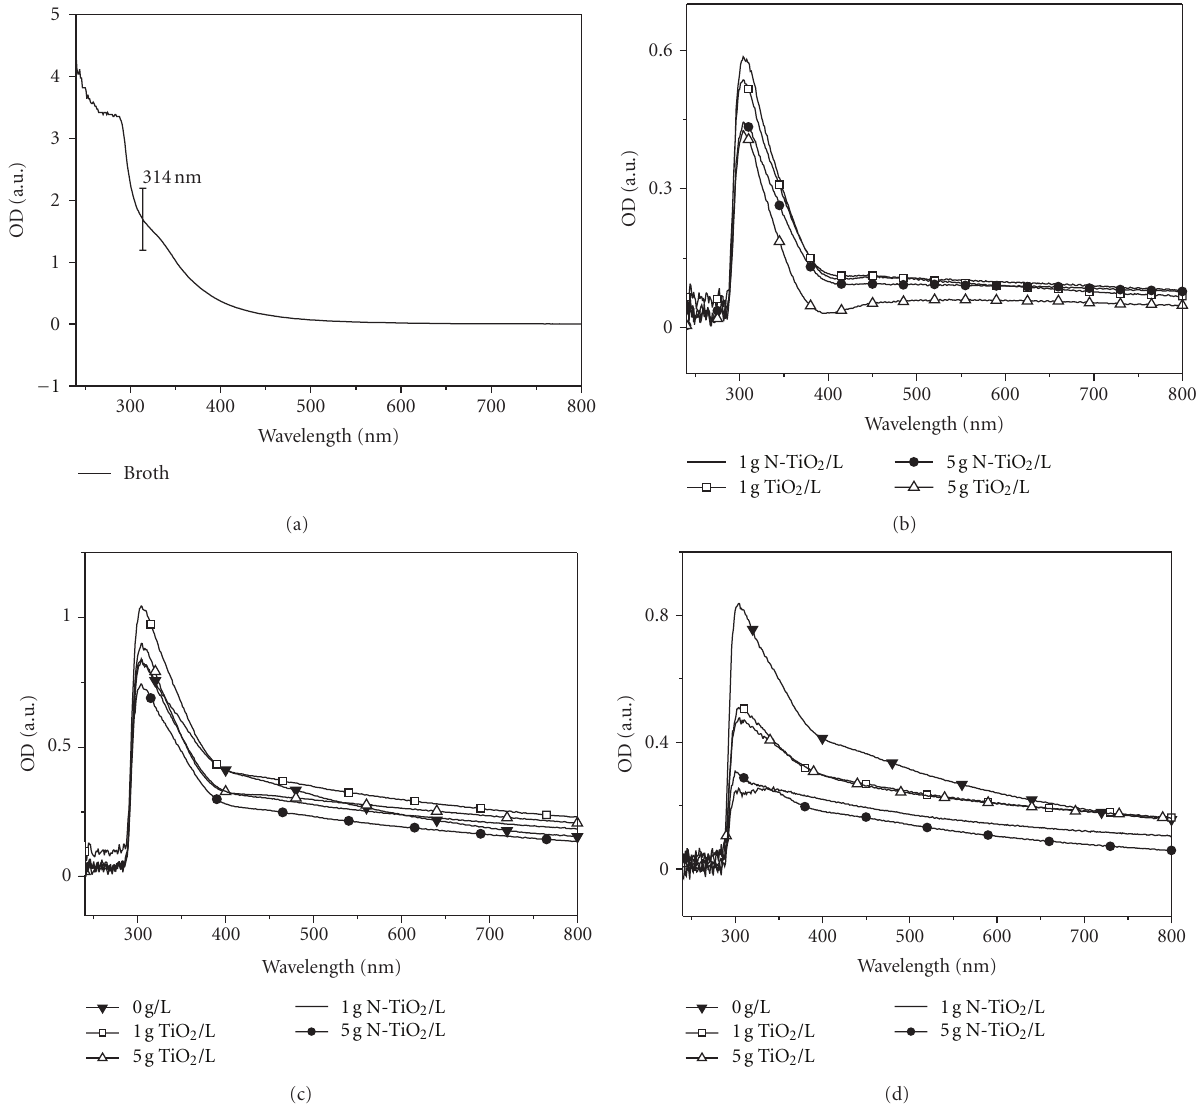
Figure 5: The optical density of nutrient broth (a), nutrient with photocatalyst (b), and experiment suspensions (c) exposed to 405 nm LED (0.2W/cm 2 ) for 3 hours (employed bare nutrient broth for reference axis), (d) is the di ff erence value between (b) and (c). di ff erence between the OD 600 values of each experimental sample and the nutrient broth suspension with suspended nanoparticles at corresponding concentration but in absence of